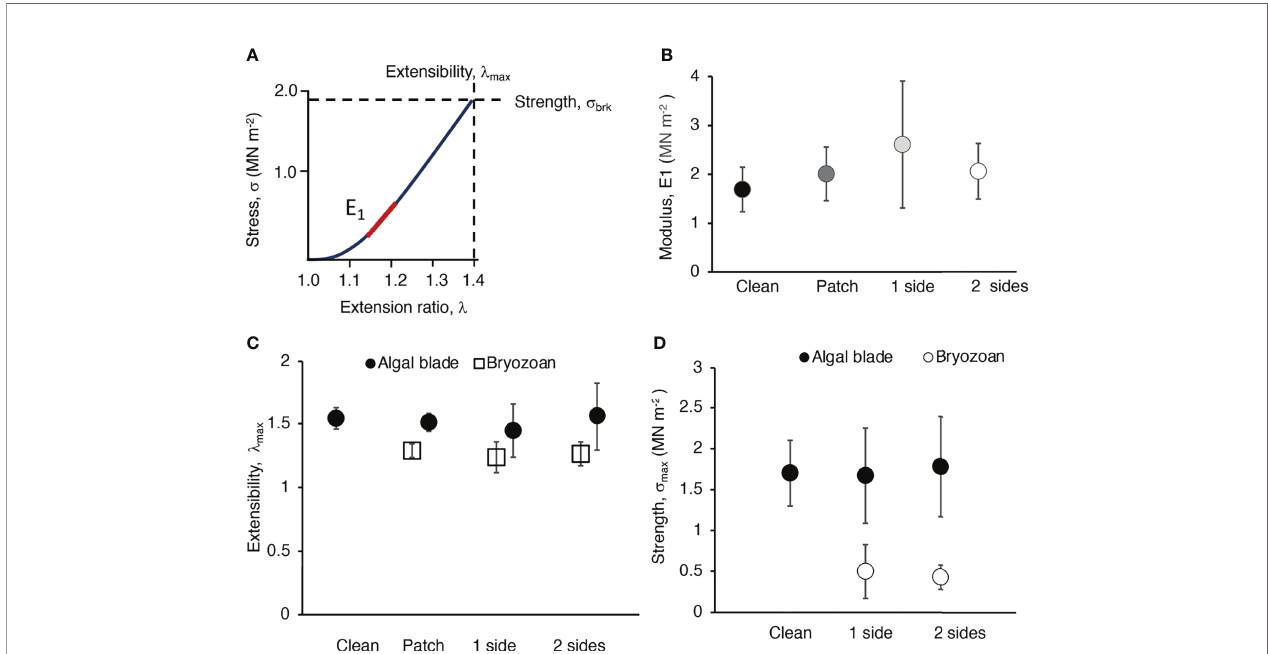
FIGURE 10 | Material properties of blade tissue of M. splendens and of colonies of M. membranacea. (A) Stress ( s ) plotted as a function of extension ratio ( l ) for a strip of blade of a M. splendens . The stiffness of the blade tissue (elastic modulus, E) is the slope of this curve. Because the slope changes with l , we used the slope of the s fi rst linear part of the curve (indicated by the red line) to determine the elastic modulus (E 1 ). The strength of the blade tissue is the stress at which it breaks ( brk ), and the extensibility of the tissue is the extension ratio at which it breaks ( l max ). (B) Stiffness (E 1 ) of blade tissue without epibionts (clean, black circle), blade tissue with a small bryozoan colony that did not extend into the grips of the Tensometer (patch, dark grey circle), blade tissue with 100% cover of a bryozoan colony on one side that extended into the Tensometer grips so that both algal and bryozoan tissues were being pulled (1 side, light grey circle), and blade tissue with 100% bryozoan cover on both sides that extended into the grips (2 sides, white circle). There was no signi fi cant difference between the E 1 ’ s of any of these treatments (p > 0.05, one-way ANOVA followed by Tukey HSD test, F= 1.70 3,21 ). (C) Extensibility ( l max ) of algal blade tissue (black circles) when clean, and when fouled by bryozoans (as described in B ). White squares show the l ’ s at which the bryozoans popped off the blade (patch) or broke (1 side and 2 sides). The l max of clean algae and algae with a small bryozoan colony were not signi fi cantly different (p > 0.05), but the l at which small bryozoan colonies popped off algal blades was signi fi cantly lower than the l max of the algal tissues (p < 0.01, one-way ANOVA followed by Tukey HSD test, F = 18.30 2,10 ). The l max of bryozoan colonies on one side of and algal blade was signi fi cantly lower than the l max of the algal tissue (p < 0.05, one-way ANOVA followed by Tukey HSD test, F = 5.06 1,12 ). Similarly, the l max of bryozoan colonies on both sides of an algal blade was signi fi cantly lower than the l max of the algal tissue (p < 0.01, one-way ANOVA followed by Tukey HSD test, F = 10.83 1,16 ). (D) Strength ( s brk ) of algal blade tissue (black circles) and bryozoan colonies (white circles) when clean and when fouled as described in (B). A one-way ANOVA for the fi ve treatments shown in the graph was followed by pairwise comparison using a Tukey HSD test (F = 21.42 4,33 ). The s brk of algal blades (when clean or with bryozoans on one or two sides) was signi fi cantly higher than that of bryozoan colonies (when on one side of the host blade or when on both sides of the blade (p < 0.01 for all pairwise comparisons of algal tissue with bryozoans). The s brk of clean algal blade tissue was not signi fi cantly different from that of algal tissue with bryozoans growing on one side (p > 0.05) or on both sides (p > 0.05). The